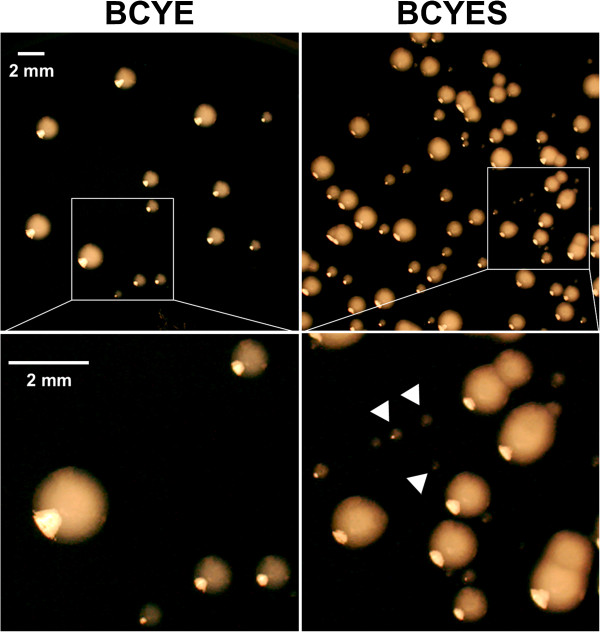
Images of the colonies observed on the standard medium (BCYE) and the standard medium supplemented with pyruvate (0.1%) and glutamate (0.5%) (BCYES). Representative results from one of two independent experiments are shown.